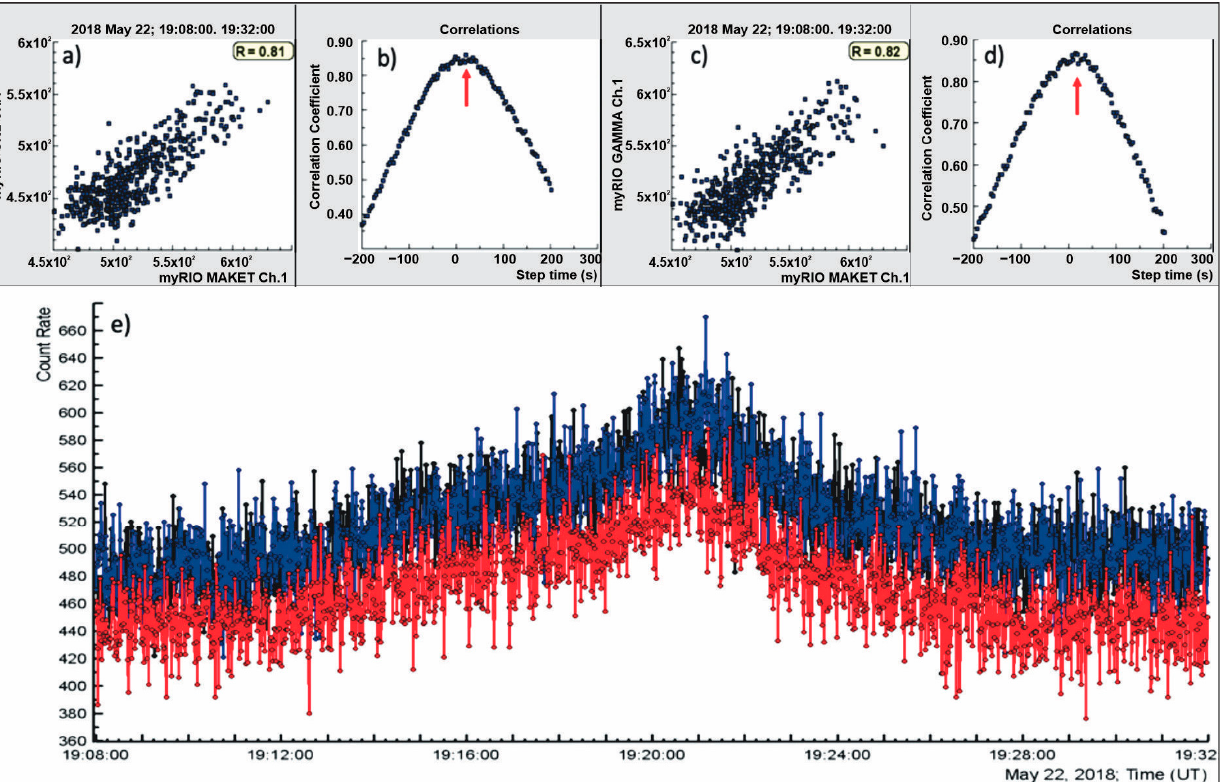
Figure 7. ( a , b ) scattering plot and plot of lagged correlations of count rates of upper scintillators of the 1 cm thick STAND1 detector (MAKET and SKL detectors); ( c , d ) the same for MAKET and GAMMA detectors; ( e ) 1-second time series of all three units of STAND1 network: MAKET (black), GAMMA (blue) and SKL (red).